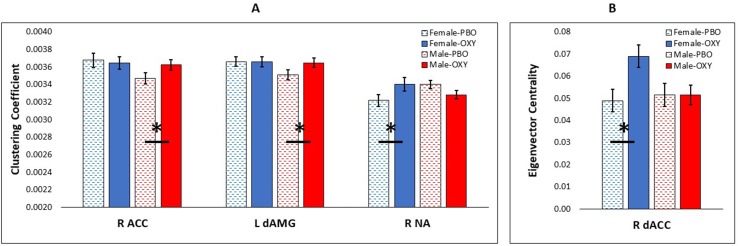
Significant effect of oxytocin (OXY) treatment (solid bars) versus placebo (PBO) (shaded bars) in CUD females (blue) and males (red). (A) Effect of OXY on clustering coefficient in three nodes of interest: right anterior cingulate cortex (R ACC), left dorsal amygdala (L dAMG), and right nucleus accumbens (R NA). (B) Effect of OXY on eigenvector centrality in one node: right dorsal ACC (R dACC). Error bars are standard error of the mean. Horizontal bars with asterisk indicate a significant difference of OXY versus PBO at p < 0.05.